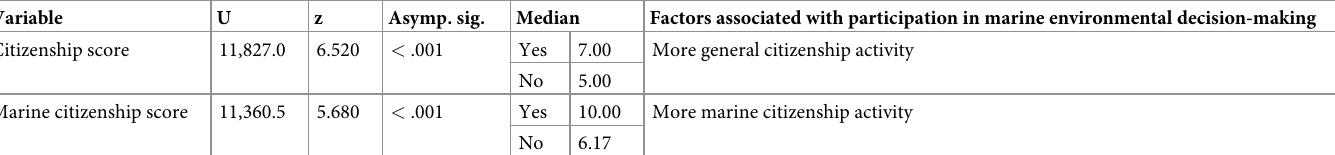
Table 6. Relationship between participation in marine environmental decision-making and citizenship scores. Participation in marine environmental decision-mak- ing (yes vs no) according to general citizenship score and marine citizenship score, via Mann Whitney-U. Variable U z Asymp. sig. Median Factors associated with participation in marine environmental decision-making Citizenship score 11,827.0